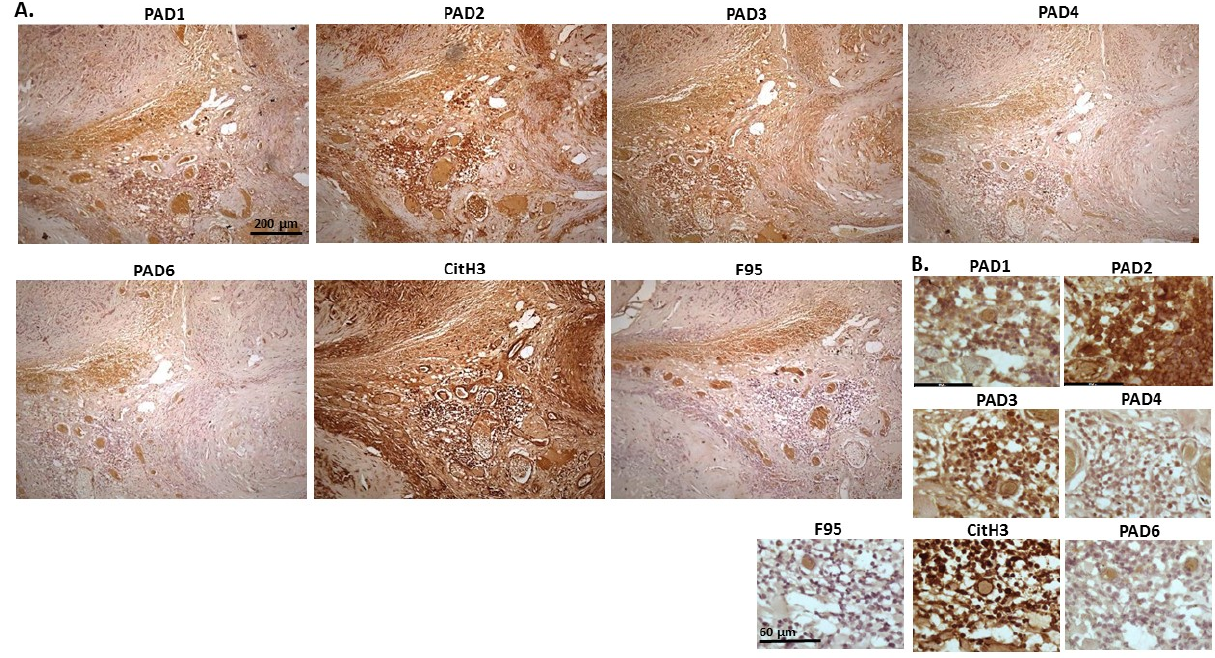
Figure 19. Dog; biopsy from a tumour in mammary gland of an eight-year-old bitch. Scirrhous adenocarcinoma in mammary gland. ( A ) Overview images for PAD1, 2, 3, 4, 6, CitH3 and F95 stainings of serial tissue sections; scale bar represents 200 μ m for all images; 10× objective. ( B ) Higher magnification shown for each staining from the images in ( A ); scale bar represents 60 μ m for all images; 40× objective.